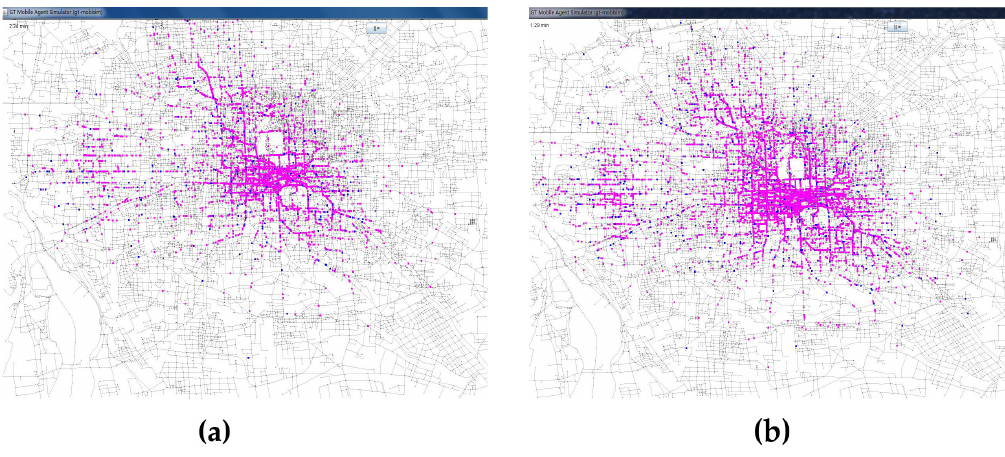
Figure 7. GT-MobiSIM. ( a ) The simultion with 5000 moving objects and 500 query objects; ( b ) The simultion with 10,000 moving objects and 1000 query